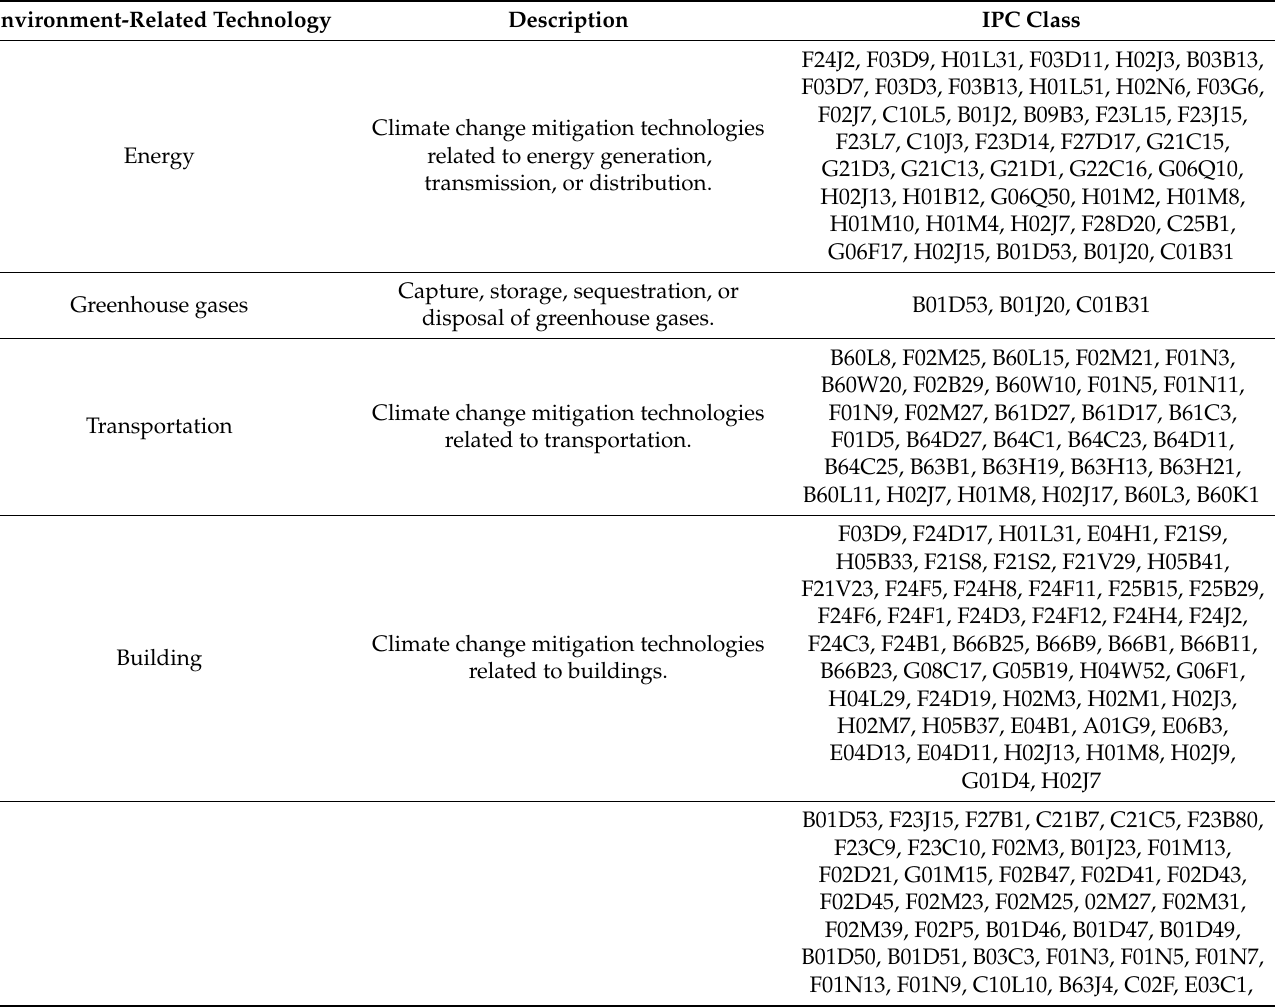
Table A1. Search strategies for the identification of environment-related